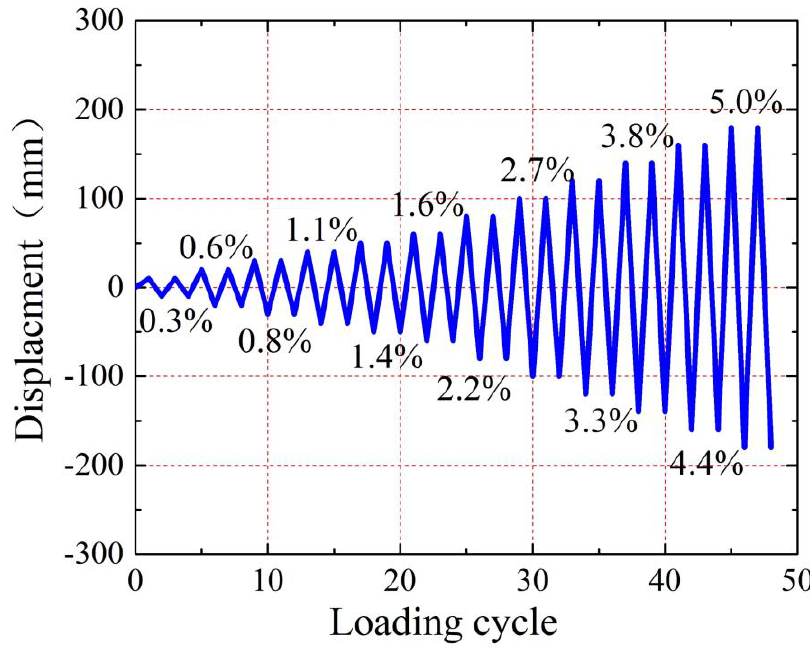
Figure 11. Quasi-static loading procedure.